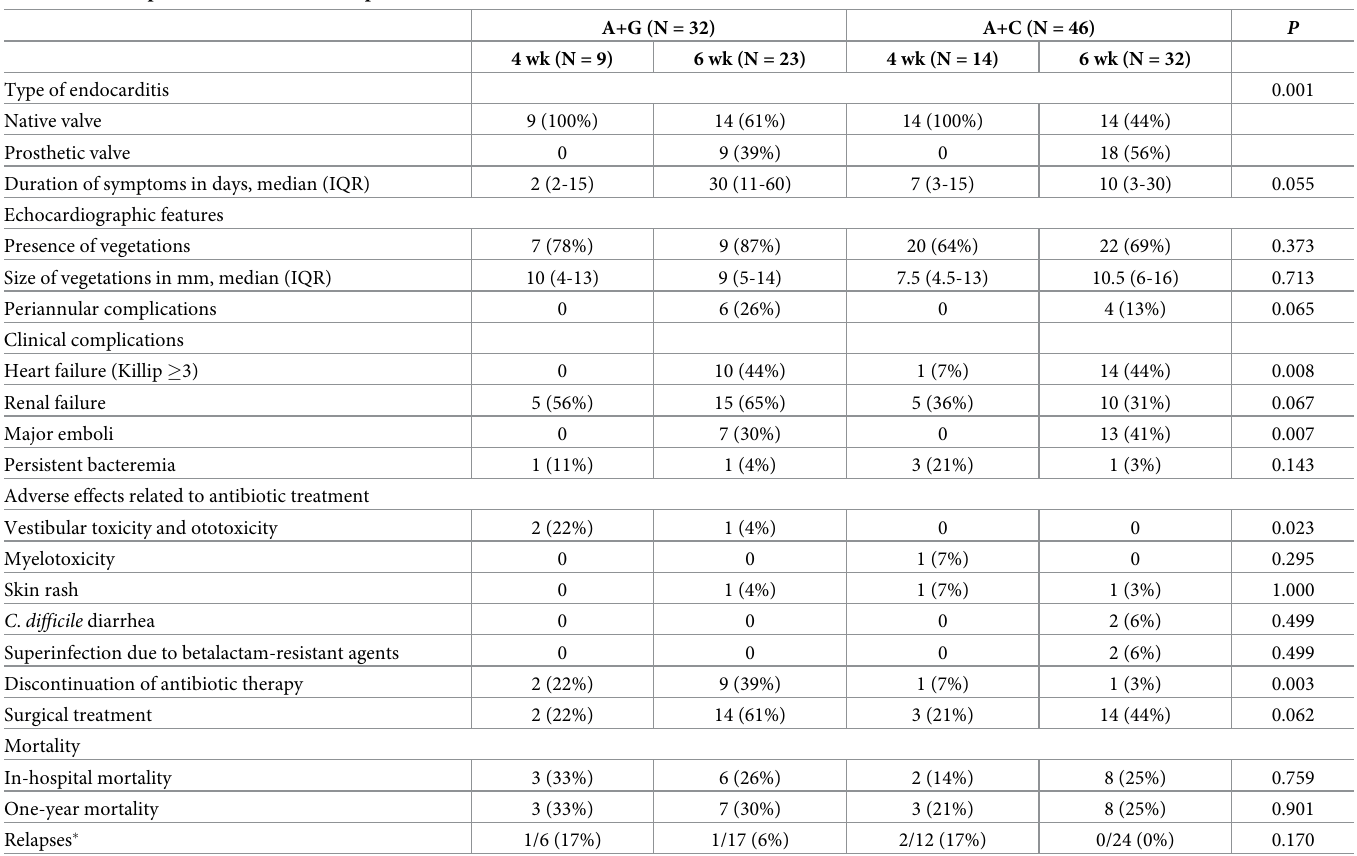
Table 2. Clinical profile and outcome of 78 patients with